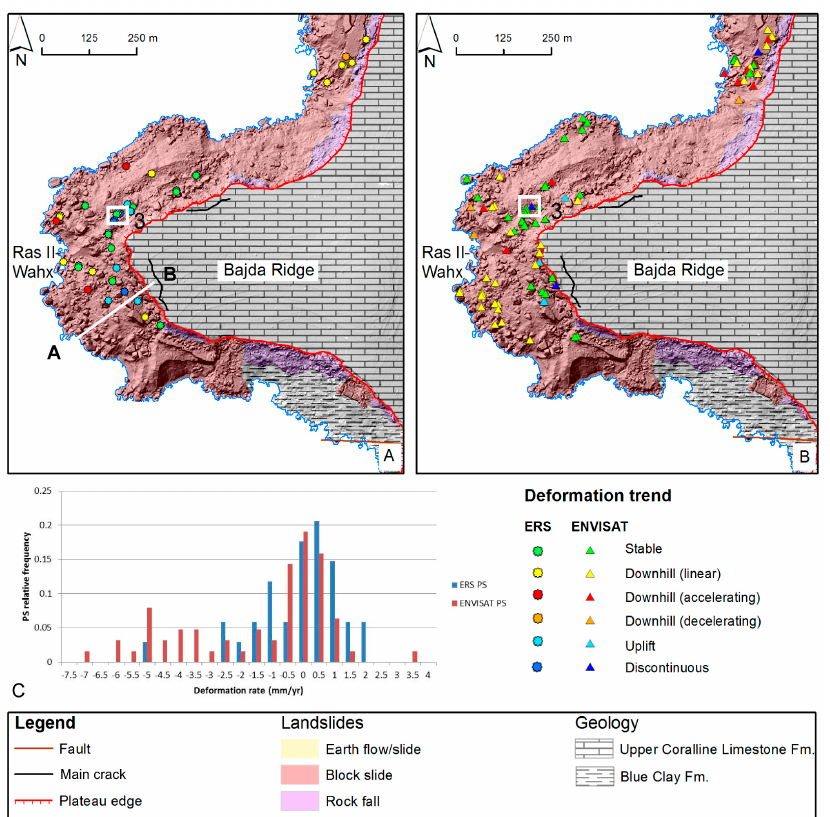
Figure 12. Ras Il-Wahx landslide map and distribution of the PS, color coded according to the trend classes defined in Figure 4: ( A ) ERS satellite PS deformation trend; ( B ) ENVISAT satellite PS deformation trend; ( C ) Histogram showing the relative frequency of occurrence in each class of movement rate. The white box on the map locates the PS whose time series are reported in Figure 6c. The white line defines the cross section of Figure 13.